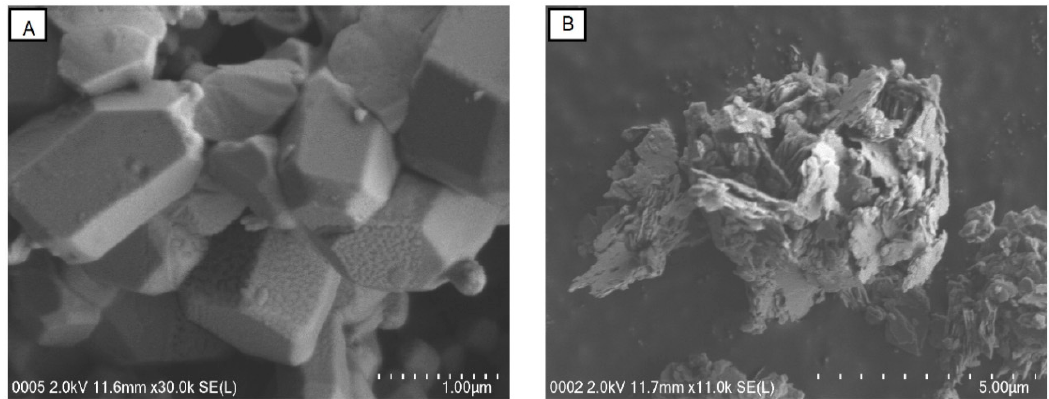
Figure 9. SEM micrograph, ( A ) purified bioflocculant QZ-7; ( B ) bioflocculant aggregation with kaolin clay.